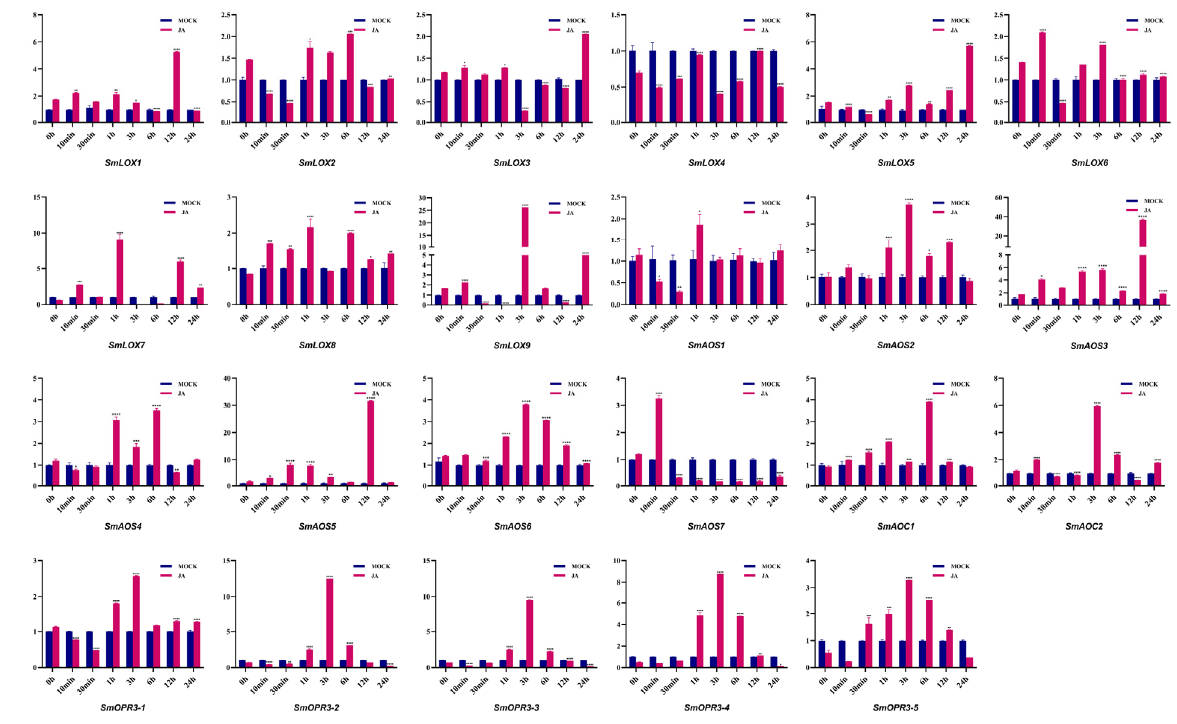
Figure 7. Expression of JA biosynthesis related genes of S. miltiorrhiza treated with MeJA for 0 h, 10 min, 30 min, 1 h, 3 h, 6 h, 12 h, and 24 h. The transcript levels were analyzed using the qRT-PCR method. Asterisks ( p < 0.05) indicate significant differences compared with the control group (* p < 0.05, ** p < 0.01, *** p < 0.001, **** p < 0.0001).